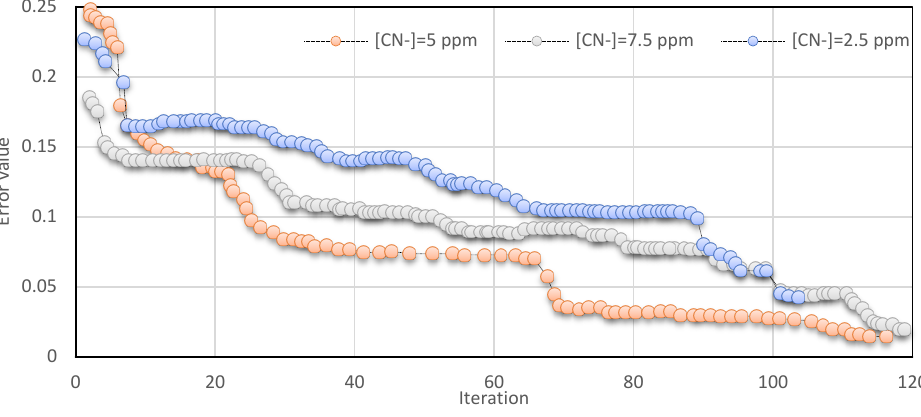
Figure 8. The trend of cost functions in different iterations.